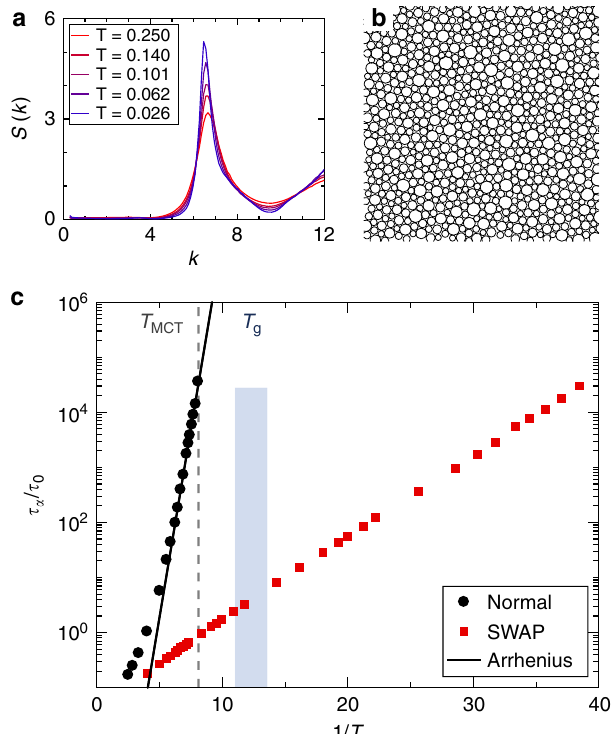
Fig. 1 Statics and dynamics of the d = 2 glass former. a The smooth evolution of the static structure factor from T onset down to the lowest studied temperature T = 0.026 indicates that the system remains fully amorphous at all T . b Snapshot of an equilibrium con fi guration at T = 0.026. c Arrhenius representation of the structural relaxation time τ α using SWAP and normal Monte Carlo dynamics, rescaled by the relaxation time at the onset temperature. The mode-coupling temperature, T MCT (gray dashed line), and the estimated range of experimental glass temperature, T fi t to the low- T data provides a g (navy strip), are indicated. The Arrhenius lower bound for the growth of τ α . SWAP can equilibrate systems down to T ≈ 0.3 T fi t gives τ normal = τ (cid:1) 10 α g , where the Arrhenius 0